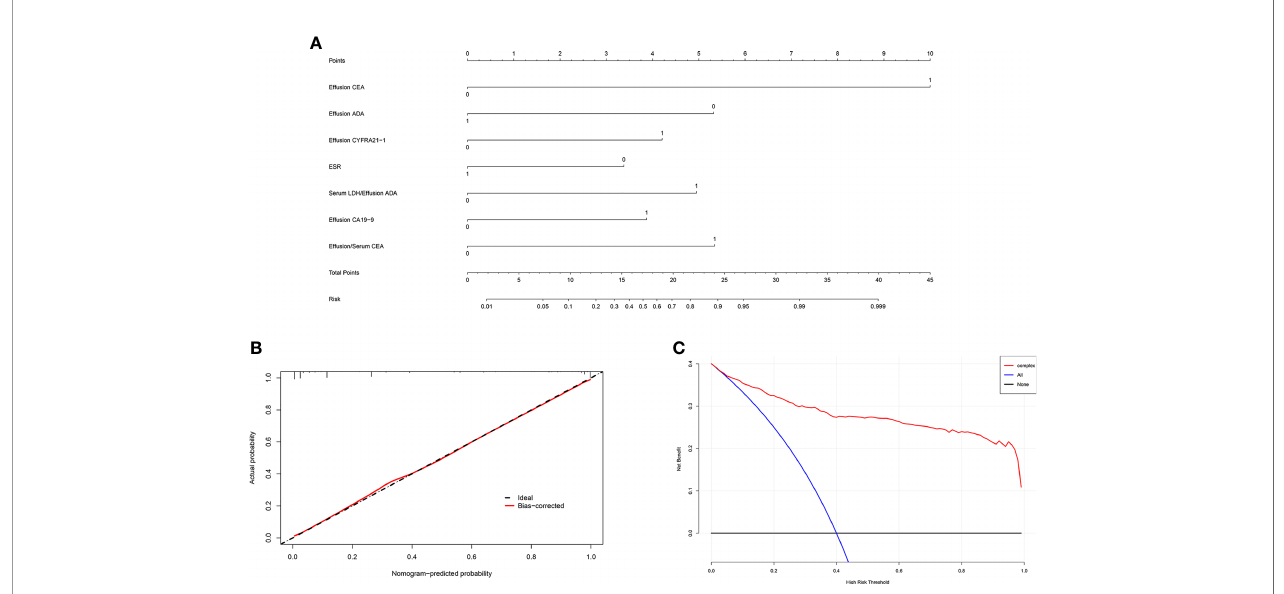
FIGURE 2 | Development and validation of the diagnostic nomogram. (A) Nomogram was developed to differentiate between malignant pleural effusion (MPE) and benign pleural effusion (BPE) in the training set. (B) Calibration curve of the nomogram. (C) Clinical usefulness of the diagnostic